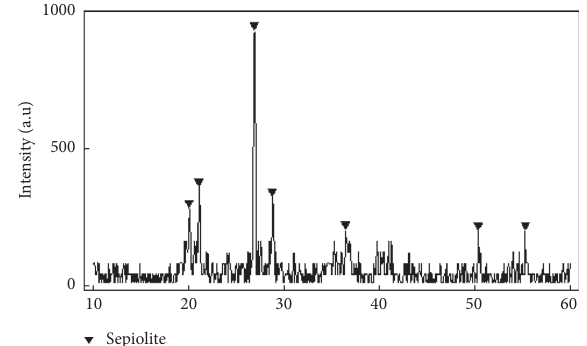
Figure 18: XRD pattern of the modified